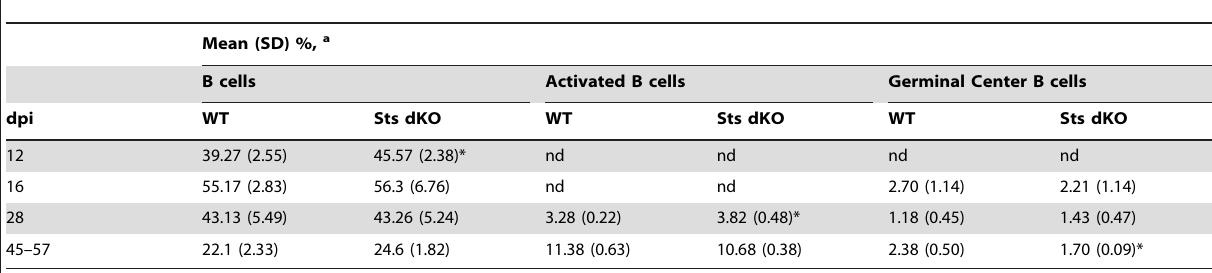
Table 3. B cell subsets in the spleens of infected